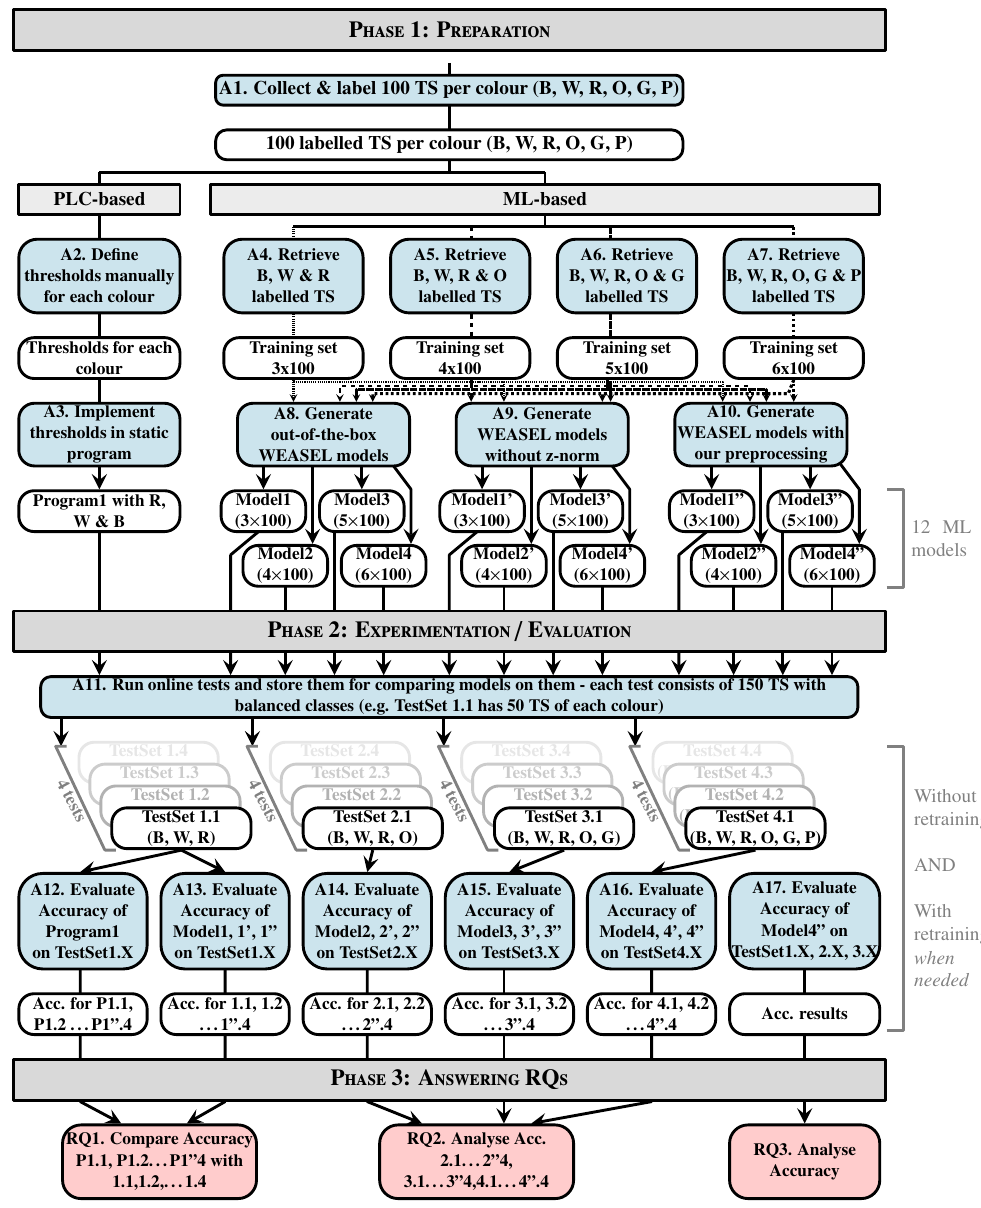
Figure 5. Methodology for models preparation, creation, and evaluation: the blue boxes correspond to the activities, the white ones to the input/output, the grey ones to the different phases, and the pink ones to the analyses for answering the research